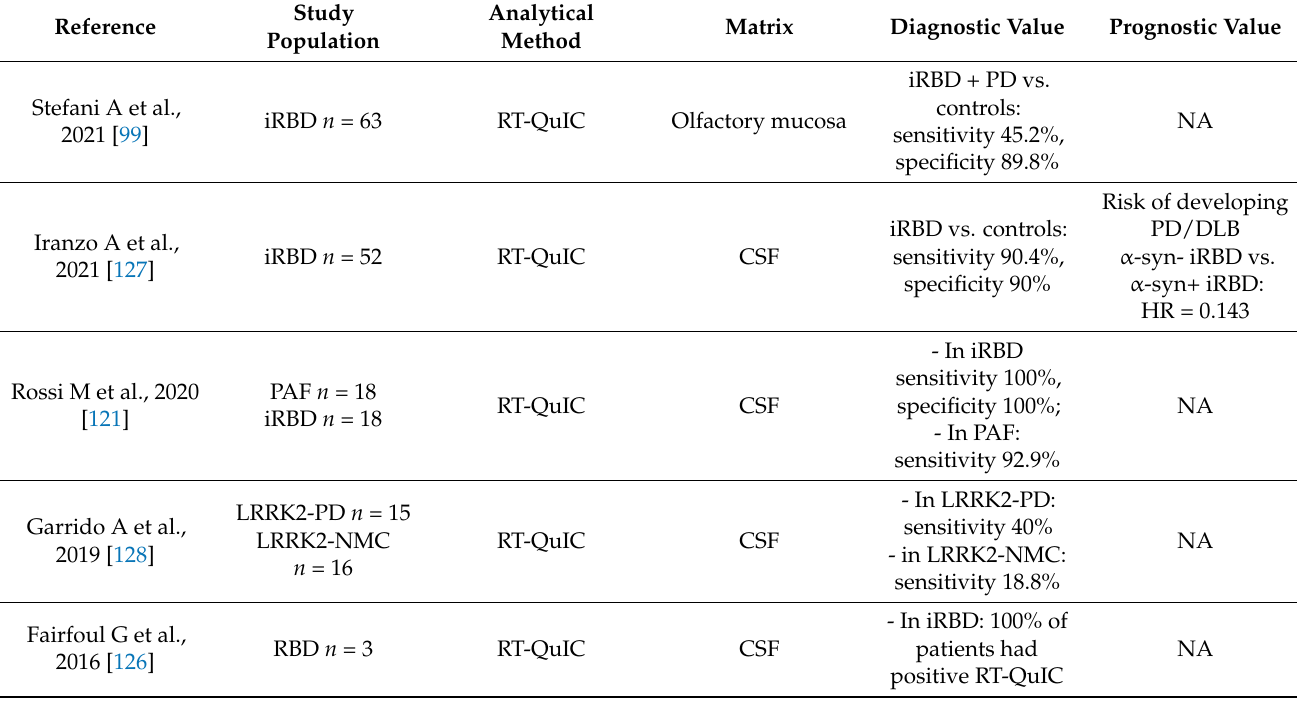
Table 4. Performance of α -synuclein RT-QuIC in populations at higher risk for α -synucleinopathies assessed in CSF and in the olfactory